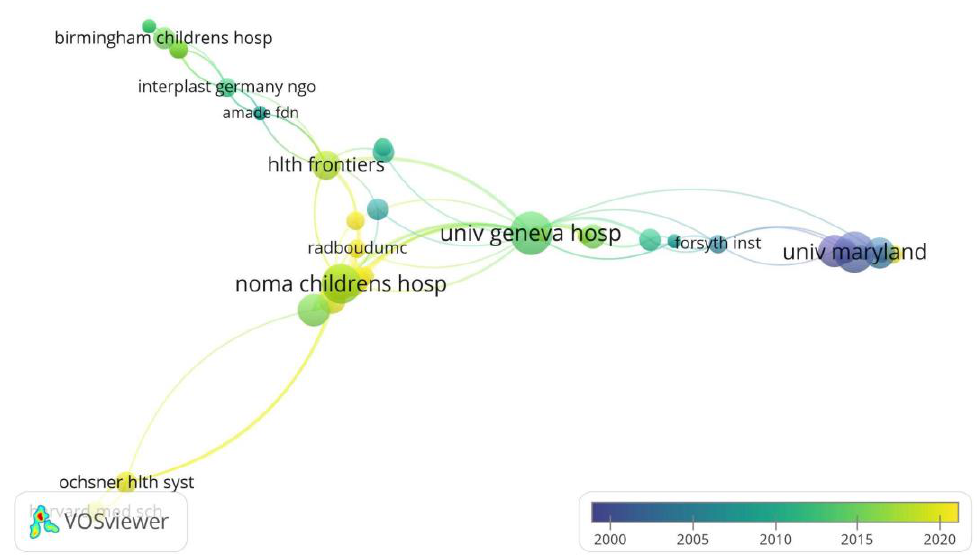
Figure 5. Network analysis of co-occurrence of terms.